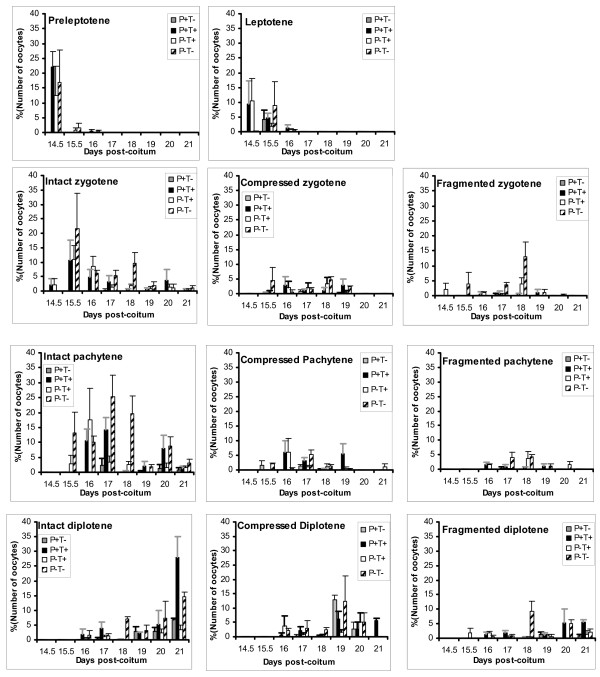
Distribution of oocytes at each stage of meiotic prophase I between 14.5 and 21 dpc according to their labelling for cleaved PARP-1 and/or TUNEL. Oocytes with intact axial elements between zygotene and diplotene stages are presented in separate graphs (left) in parallel with oocytes having compressed or fragmented axial elements at the same stage (right).